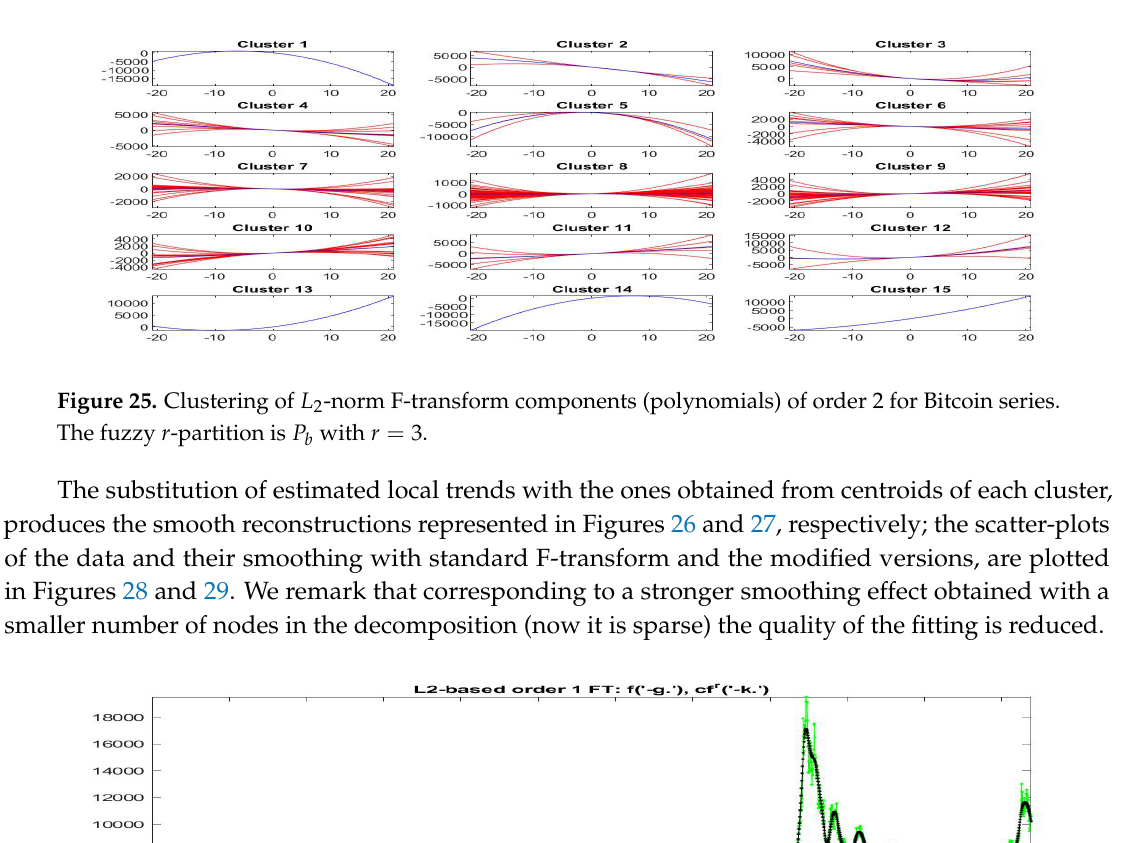
Figure 26. L 2 -norm modified iF-transform values f q fuzzy r -partition is P b with r =